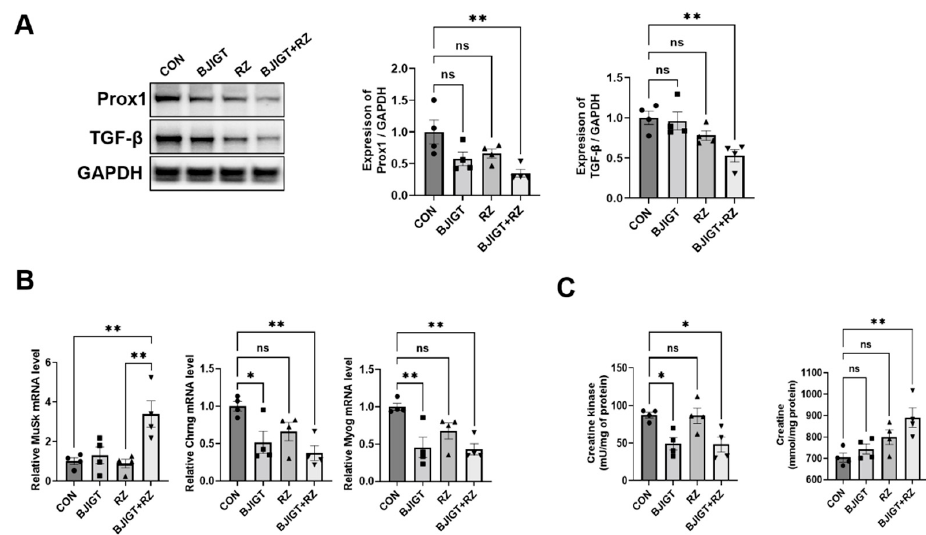
Figure 4. Combined BJIGT/RZ treatment improves muscle denervation in the GC of the hSOD1 G93A ALS mouse model. ( A ) Representative Western blots depicting the alteration of muscle denervation- related proteins, including prospero homeobox protein 1 (Prox1) and transforming growth factor- β (TGF- β ), in the GC of each group of hSOD1 G93A mice. GAPDH was used as the loading control to normalize the protein levels. Quantification of bands showing the levels of Prox1 and TGF- β in the drug treatment groups compared with those in the control group ( n = 4/group). ( B ) Quantitative analysis of the relative mRNA expression of genes involved in muscle denervation including muscle- specific kinase ( MuSK ), cholinergic receptor nicotinic gamma subunit ( Chrng ), and myogenin ( Myog ) in the GC of each group of hSOD1 G93A mice ( n = 4/group). ( C ) Quantitative analysis of the levels of CK and creatine in the GC of each group of hSOD1 G93A mice ( n = 4/group). Data are normalized to the control group data and presented as mean SEM. ns: not significant, * p < 0.05 and ** p < 0.01, ± compared with the control group. DW-administered transgenic (Tg) mice (CON), BJIGT-treated Tg mice (BJIGT), RZ-treated Tg mice (RZ), and combined BJIGT/ RZ-treated Tg mice (BJIGT+RZ). The different number of circles, squares, and triangles are indicated the number of sample